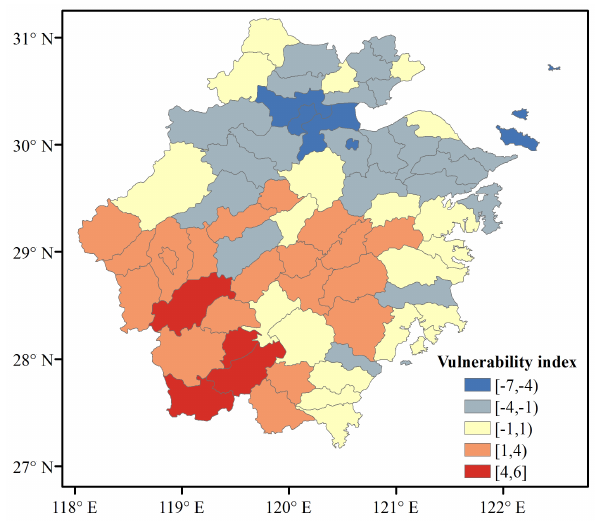
Figure 10. Distribution of population vulnerability index of coun-